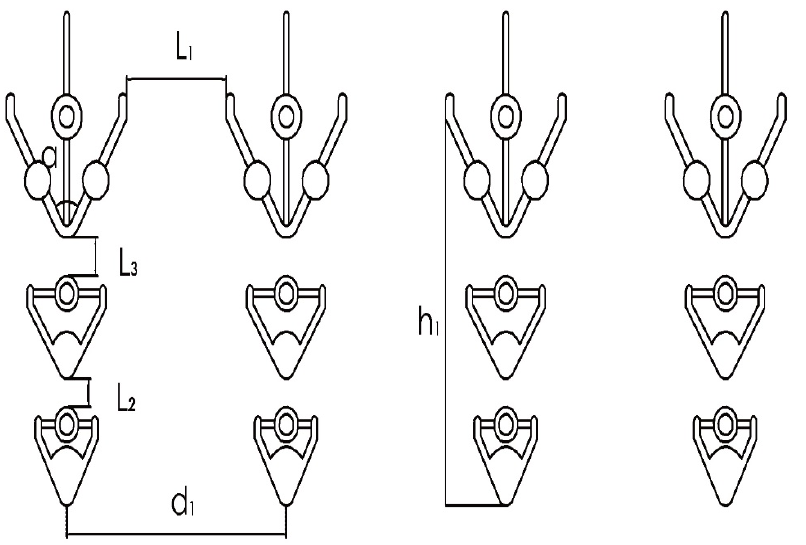
Figure 5. Cross-sectional view of the cryosorption pump.